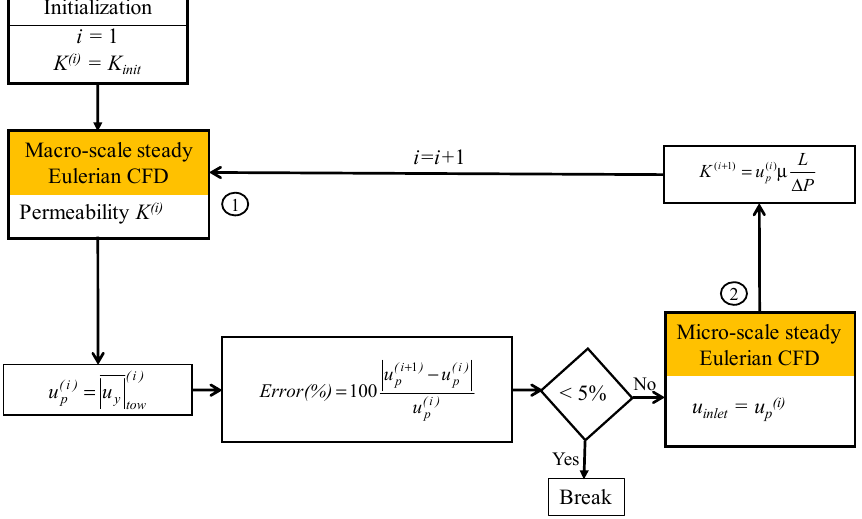
Figure 6. Sequential coupling strategy of multiscale CFD simulation to predict the permeability of resin through porous tows for the production of thermoplastic carbon fibers (modified from Ngo et al. (2017) [29]).